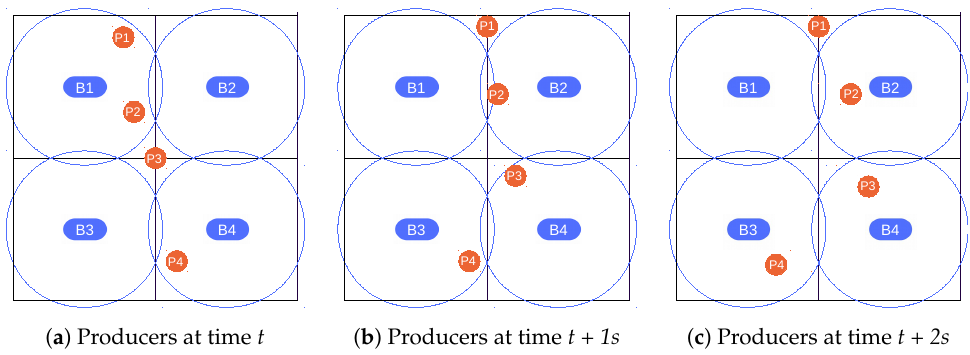
Figure 6. Example of area grid and producers’